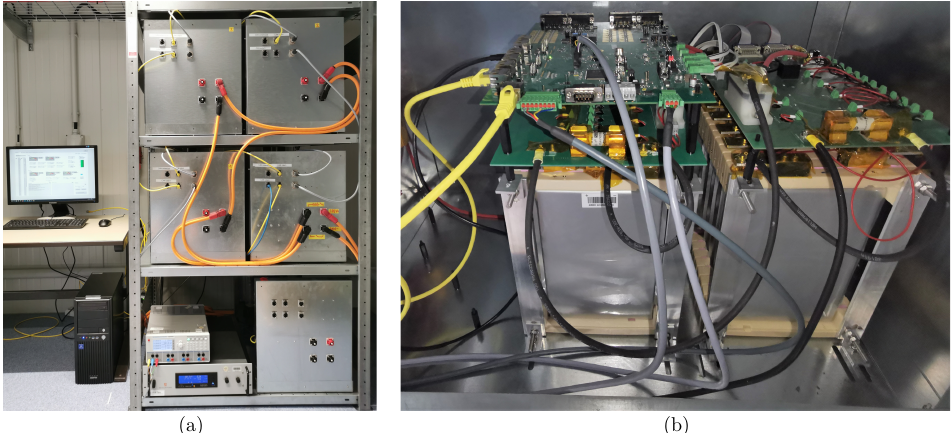
Figure 6. Experimental setup. ( a ) Battery system consisting of four battery modules, the SM 500-CP- 90 inverter and LabVIEW program for data extraction. ( b ) Inside view of a battery